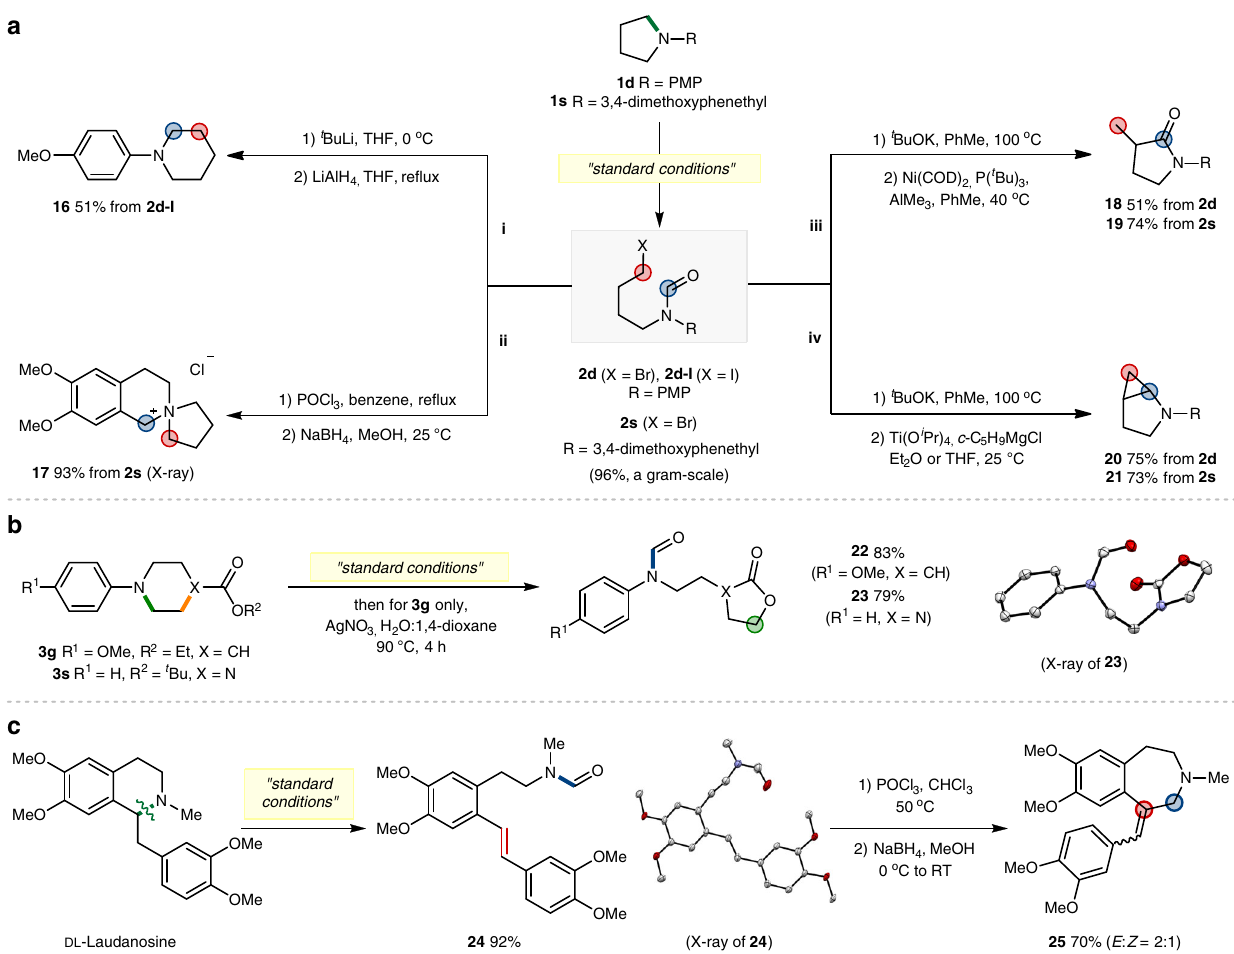
Fig. 7 Skeletal diversi fi cation. a Skeletal remodelling of pyrrolidine rings. i, ring-expansion. ii, synthesis of spiro-bicyclic compound through the Bischler – Napieralski reaction. iii, synthesis of γ -lactam products by hydrocarbamoylation of E2 products. iv, synthesis of ring-fused products by the Kulinkovich – de Meijere reaction. b Skeletal remodelling of 6-membered rings by using a pre-installed nucleophile. c Ring-diversi fi cation of natural product: Ring-expansion of